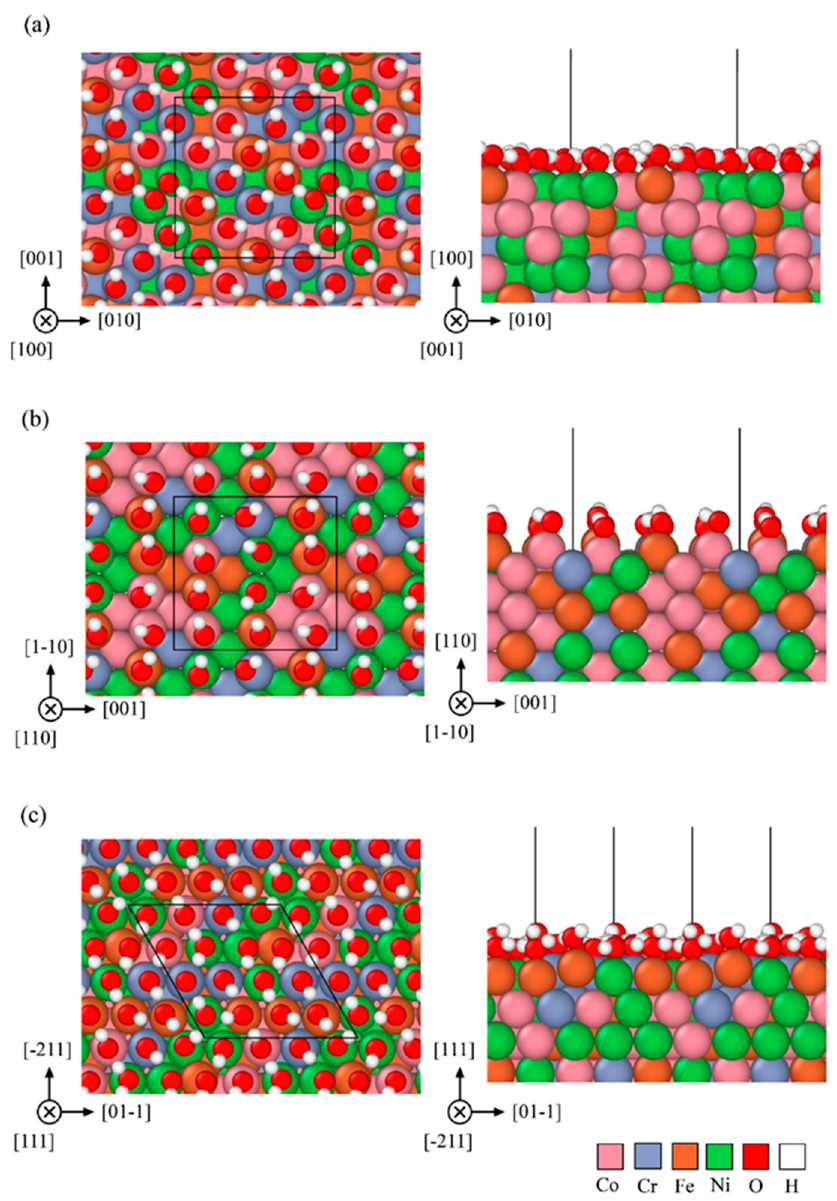
Figure 10. Top and side views of the atomic geometry of monolayer OH on facets ( a ) (100) ( b ) (110), and ( c ) (111) of FCC structure for CoCrFeNi specimens derived from the first-principles calculations.